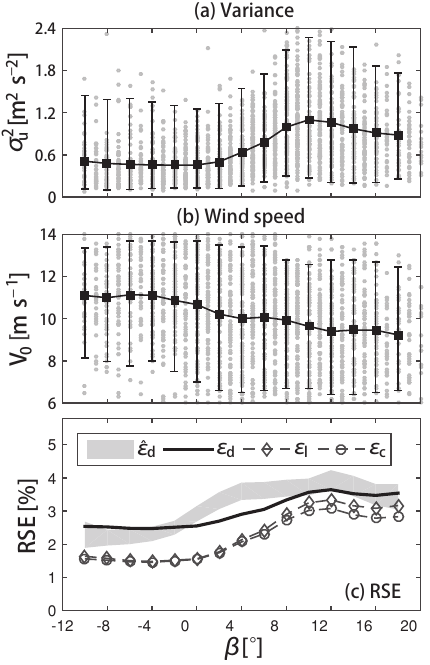
Figure 8. Variation of the standard error (RSE) with the relative direction ( β ) at Site C at 80m height. The RSE is given in (c) for the 95% confidence interval of the observed difference between the cup and lidar measurements ( ˆ ε d ), the predicted difference between the cup and lidar measurements ( ε d ), the predicted cup error ( ε c ), and the predicted lidar error ( ε l ). The input for the RSE predictions include the mean wind speeds ( V 0 ) shown in (b) and the mean wind speed variance ( σ 2 u ) shown in (a) .